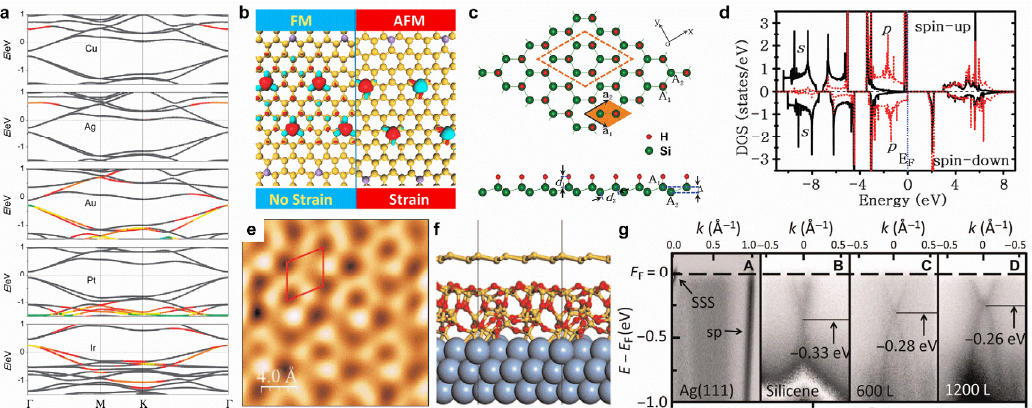
Figure 7. Surface modifications of silicene. ( a ) Electronic band structures of Cu-, Ag-, Au-, Pt-, and Ir-covered silicene with a coverage of 5.6%. The Fermi level is set to zero. ( b ) Strain-controlled magnetic exchange coupling in Mn-doped silicene. ( c ) Top and side views of the atomic structure for one-side semi-hydrogenated silicene. ( d ) Partial density of states calculated by HSE06 for semi-hydrogenated silicene. ( e ) High-resolution STM image of oxygen-intercalated epitaxial silicene grown on Ag(111). ( f ) Atomic structure of silicene/SiO x /Ag(111) from ab initio molecular dynamics (AIMD) simulation. ( g ) Energy versus k dispersion measured using ARPES for clean Ag(111) surface (A), as-grown √ 3 × √ 3 silicene formed on buffer layer (B), oxygen-intercalated silicene with an oxygen dose of 600 L (C), and intercalated silicene with an oxygen dose of 1200 L (D). ( a ) Reprinted with permission from Ref. [135]. Copyright 2014, Royal Society of Chemistry. ( b ) Reprinted with permis-